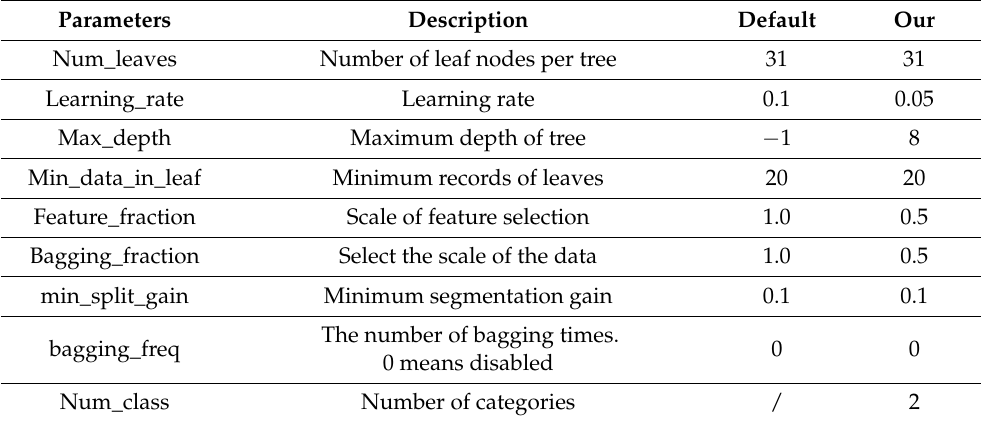
Table 2. Parameter